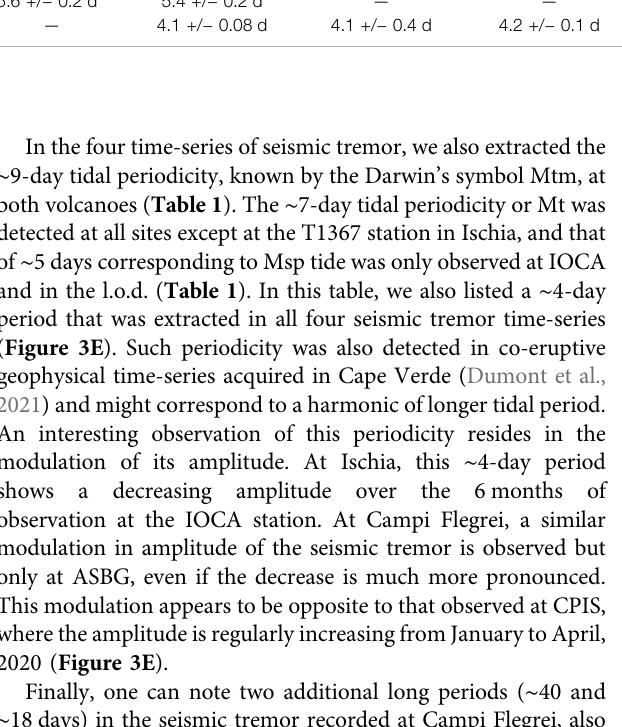
Darwin symbol (days) of